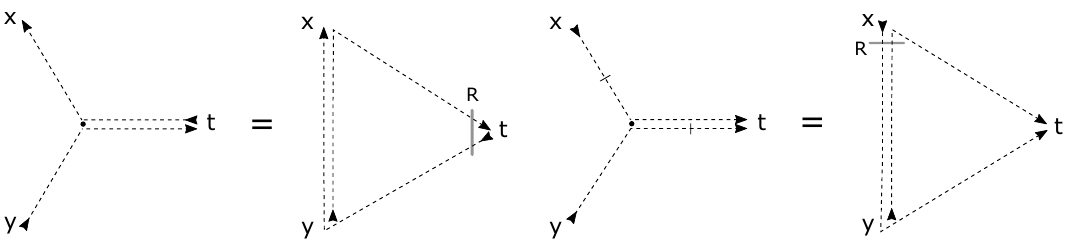
Figure 15 . Star-triangle relations for “opposite σ flow” and “same σ flow”, where the order of matrices σ , ¯ σ in the product is given by the arrows. The action of the R -matrix is represented along the spinorial structure by a grey